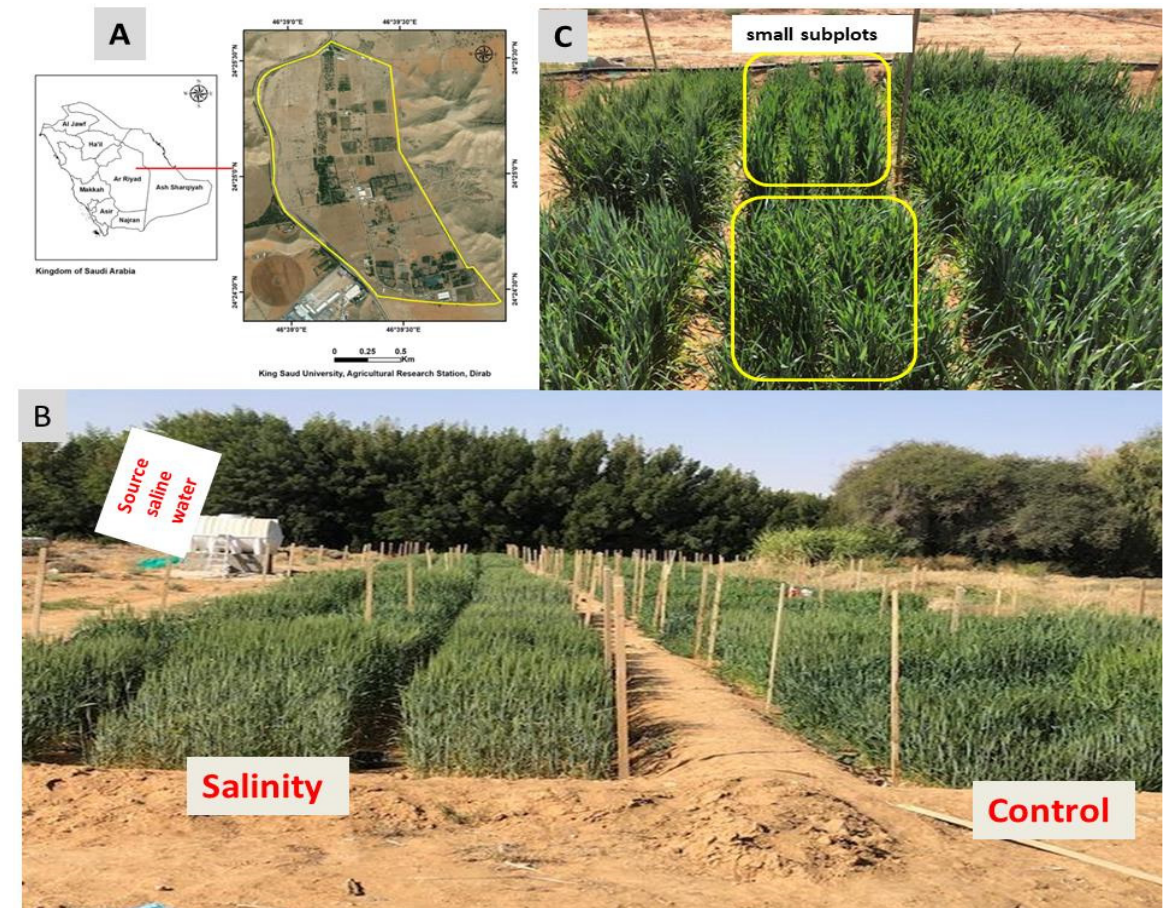
Figure 1. Location map of the experimental field ( A ), plot layouts of the control and salinity treatments ( B ), and the subplot size of the experimental field ( C ).